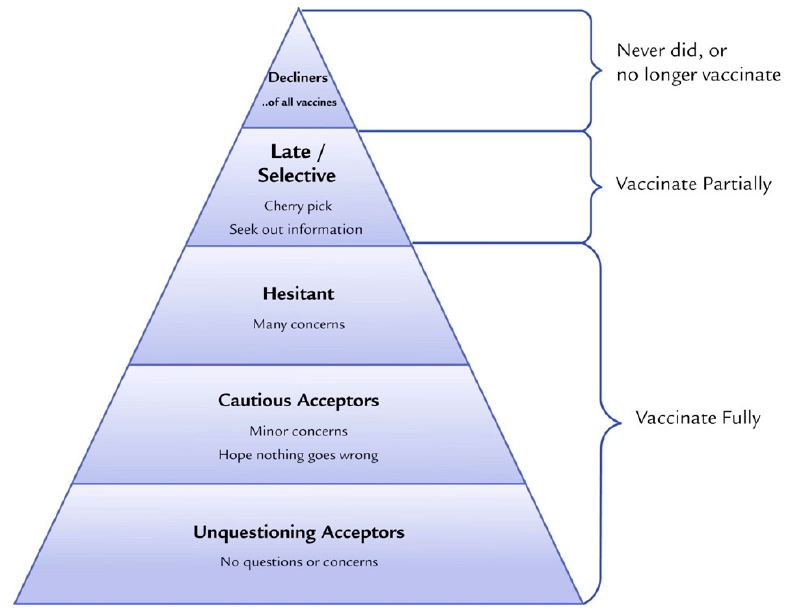
Figure 2. Vaccine acceptance spectrum from Leask et al. 2015. Improving Communication about Vaccination, adapted from Julie Leask’s online blog [60].